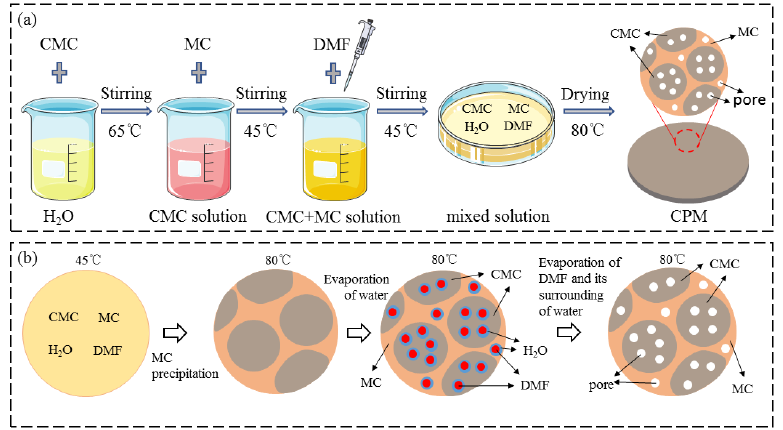
Figure 1. ( a ) Schematic illustration of the process for the preparation of CPM; ( b ) schematic illustration of nanoscale pore formation in CPM.